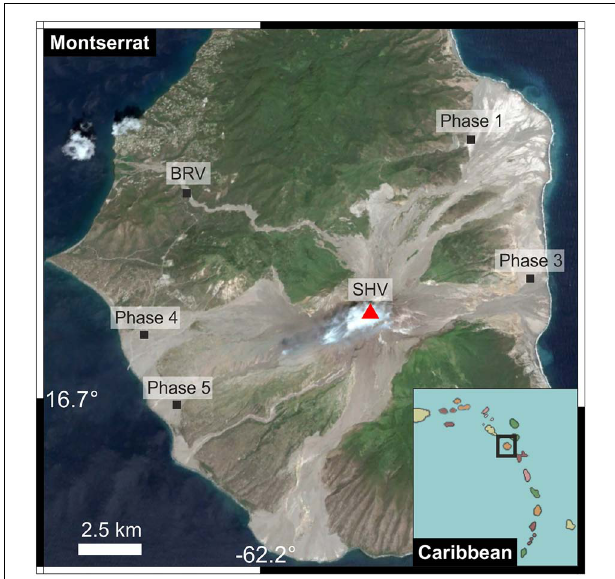
FIGURE 1 | Map of Montserrat showing landscape, including topographic lows where pyroclastic deposits have been channeled. Location of sampling sites shown for each phase. Also marked: Soufrière Hills volcano (SHV) summit (red triangle), and Belham River Valley (BRV; where additional Schmidt hammer testing was carried out). Inset shows location of Montserrat in the Caribbean islands.